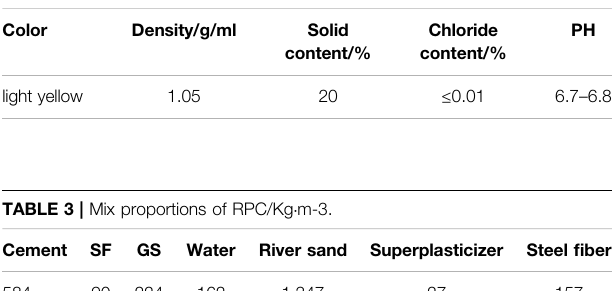
TABLE 2 | Performance index of polycarboxylate superplasticizer.